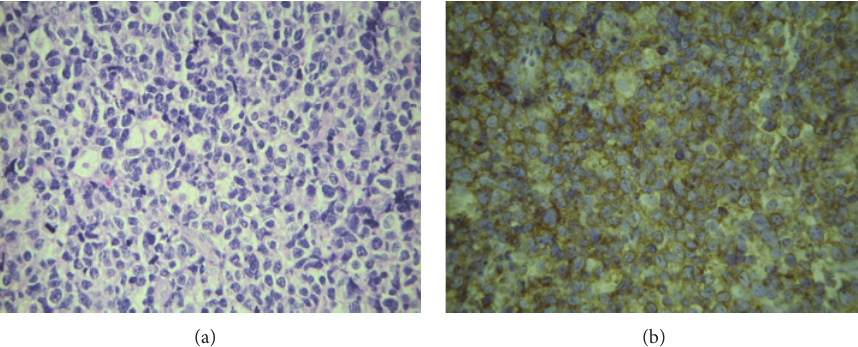
Figure 2: Picture (a) showing dense and diffuse polymorphous population of tumor cells consisting of small to medium sized and large cells with irregular nuclei. Picture (b) showing an immunohistochemistry with tumor cells expressing